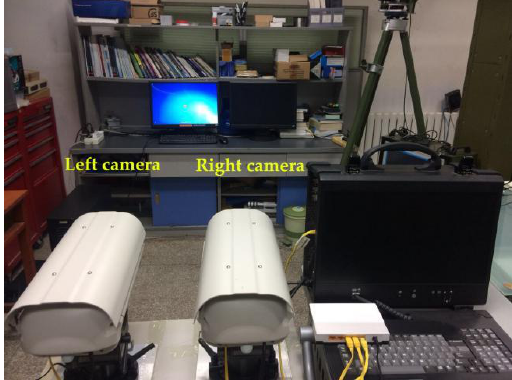
Figure 6. Experimental equipment of the binocular stereo vision. Table 1. Cameras